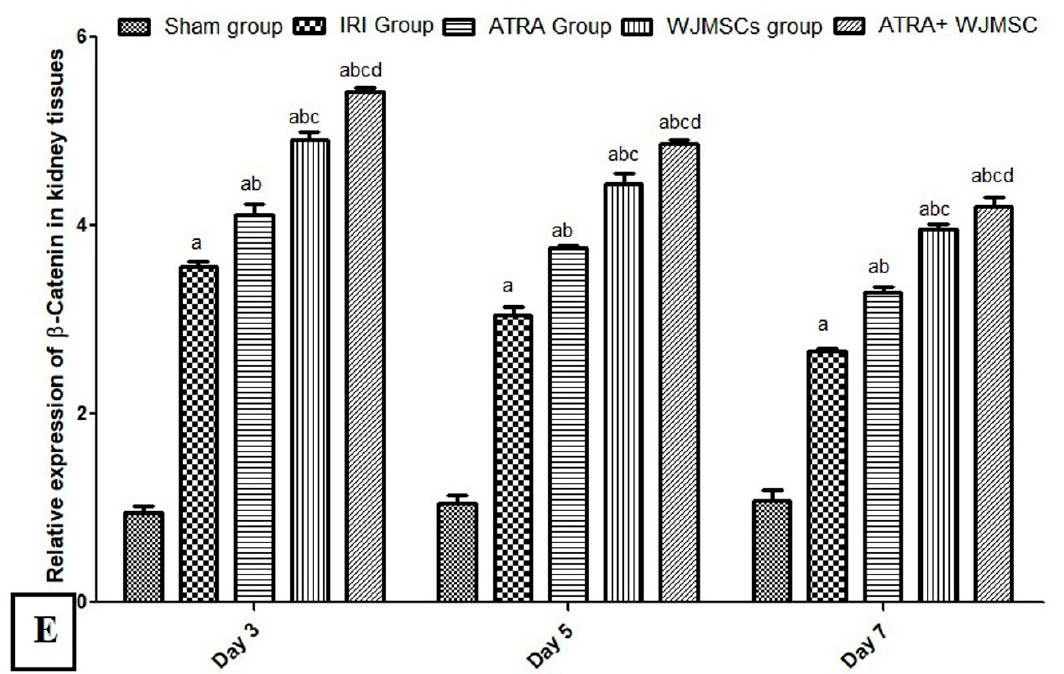
Figure 3. Effect of ATRA and WJ-MSCs on the expression of IL6 ( A ), Bax ( B ), HIF-1 α ( C ), WnT7B ( D ) and β -catenin ( E ) genes at the level of mRNA in kidney tissues ( n = 6/group). The values are mean ± SD for six rats per group. One-way ANOVA test with post-hoc Scheffe’s test (significant if p ≤ 0.05). a Significant vs. sham group of the same time interval; b significant vs. IR group of the same time interval; c Significant vs. ATRA group of the same time interval; d Significant vs. WJ-MSCs group of the same time interval.